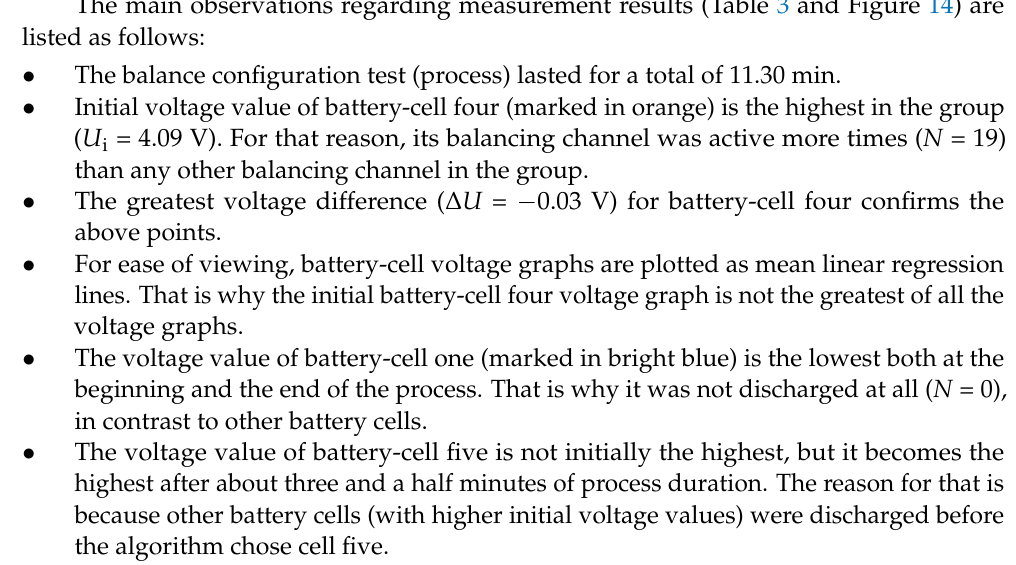
In Table 3 are: U i —initial battery-cell voltage values, U f —final battery-cell